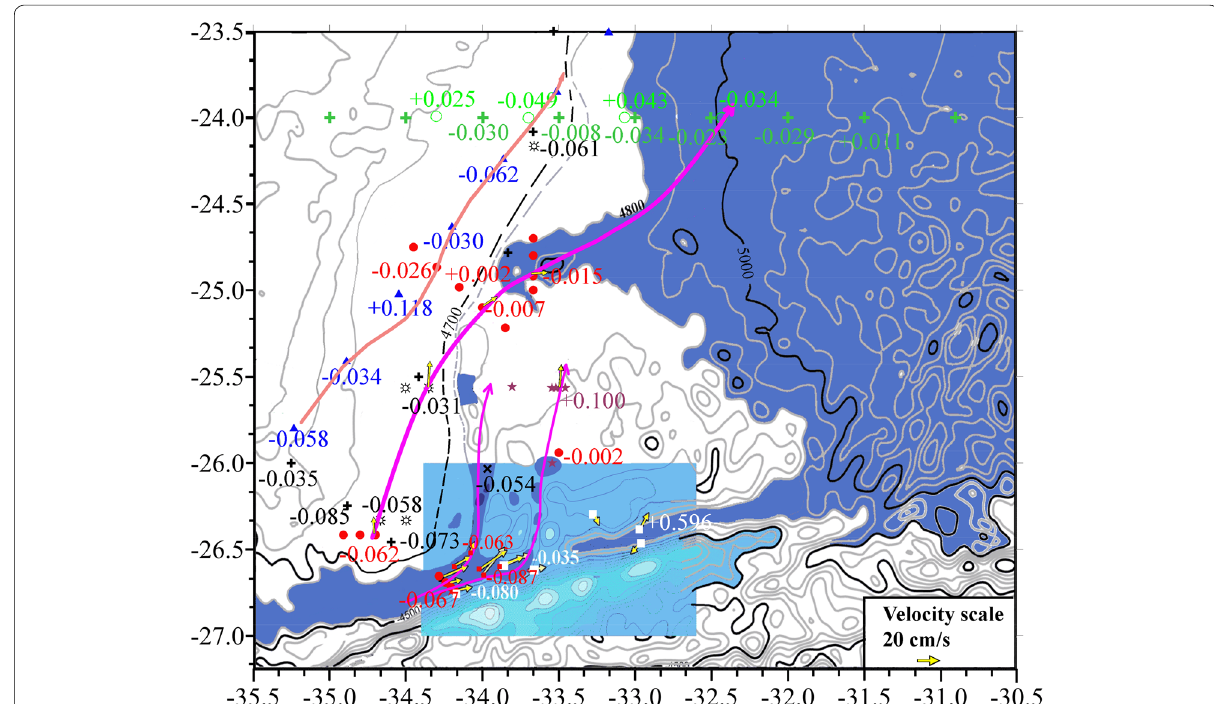
Fig. 4 Bathymetry of the study region based on (GEBCO 2019) and corrected with our echo-sounder measurements in 2010–2020. Locations of CTD/LADCP casts are shown. Blue triangles show the stations of the WOCE A17 section in 1994.Black crosses ( cross ( x ) shows the station in 2009. Green circles show stations of the A09 (24° S) section in 2009 and green crosses show the A09 stations in 2018. Small red squares are our stations in 2012. Larger white squares are our stations in 2013. Violet stars show our stations in 2018. Circles with rays (B&W) show stations in 2019. Red circles show stations in 2020. Yellow arrows show the directions of currents and their velocity (vectors). Numbers in color at the dots of stations (the same color) indicate potential temperature at the bottom. Blue colors show deep water regions, especially the canyon at 24° 40 ′ S. The blue rectangle shows a region, which was studied best of all in 2010–2020. The magenta lines show a scheme of the pathways of AABW. The beige line shows the pathway of a shallow jet based on CTD data in 1994 and 2003. Dashed lines show isobaths 4700 and 4750 m based on our echo-sounder